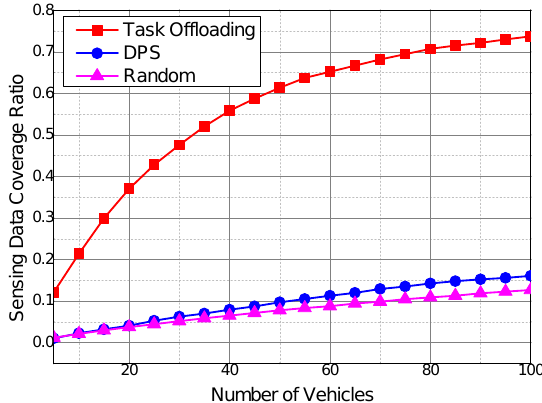
Figure 3. Impact of the number of vehicles on the sensing data coverage